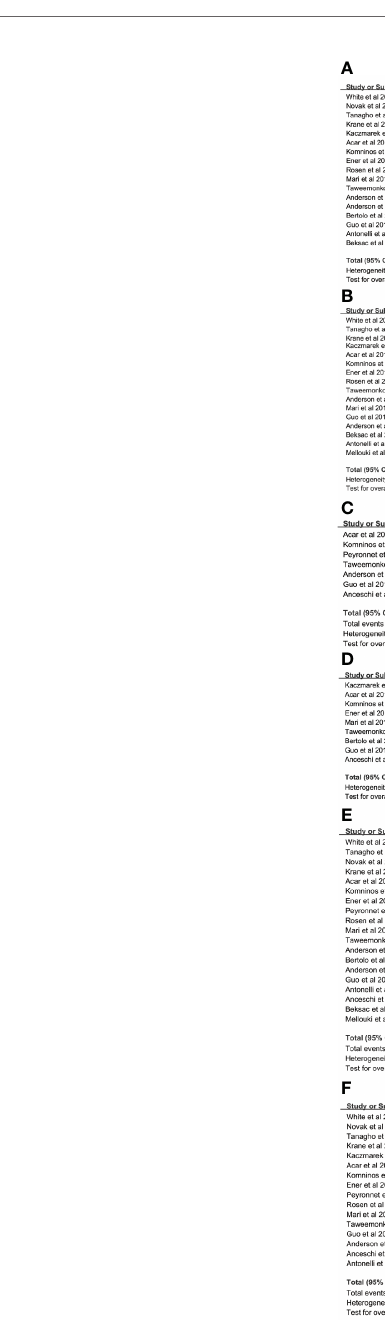
Complication rate Data of the complication rate (including intraoperative and/or postoperative complications) were available in 19 studies with a total of 3,847 patients (1,061 off-clamp versus 2,786 on-clamp) (9 – 11, 13 – 27, 29). Pooled analysis revealed a signi fi cantly lower rate of complication in the off-clamp group compared with the